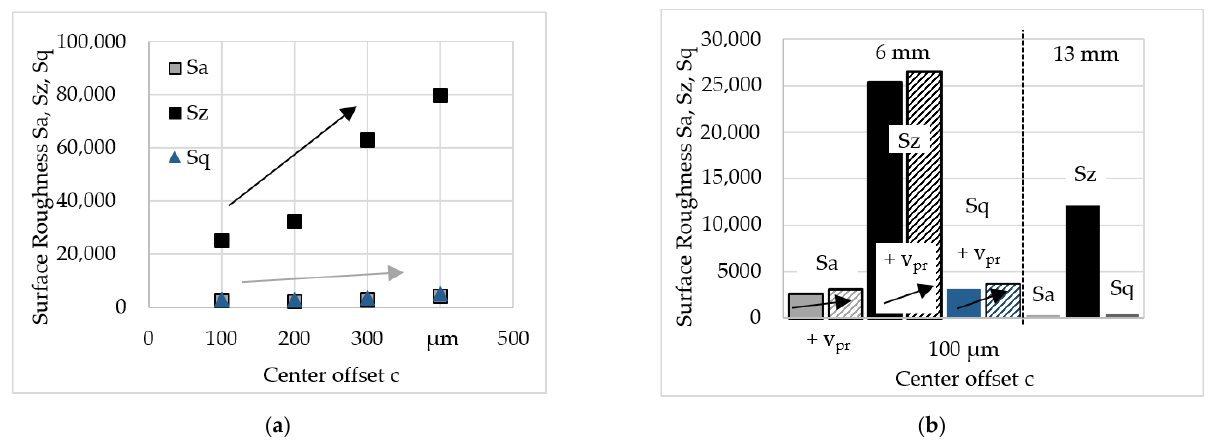
Figure 10. Influence of ( a ) the center offset, ( b ) the tool size and the process velocity on the surface roughness (filled beam: v pr = 25 mm/min, striped beam: v pr = 50 mm/min).